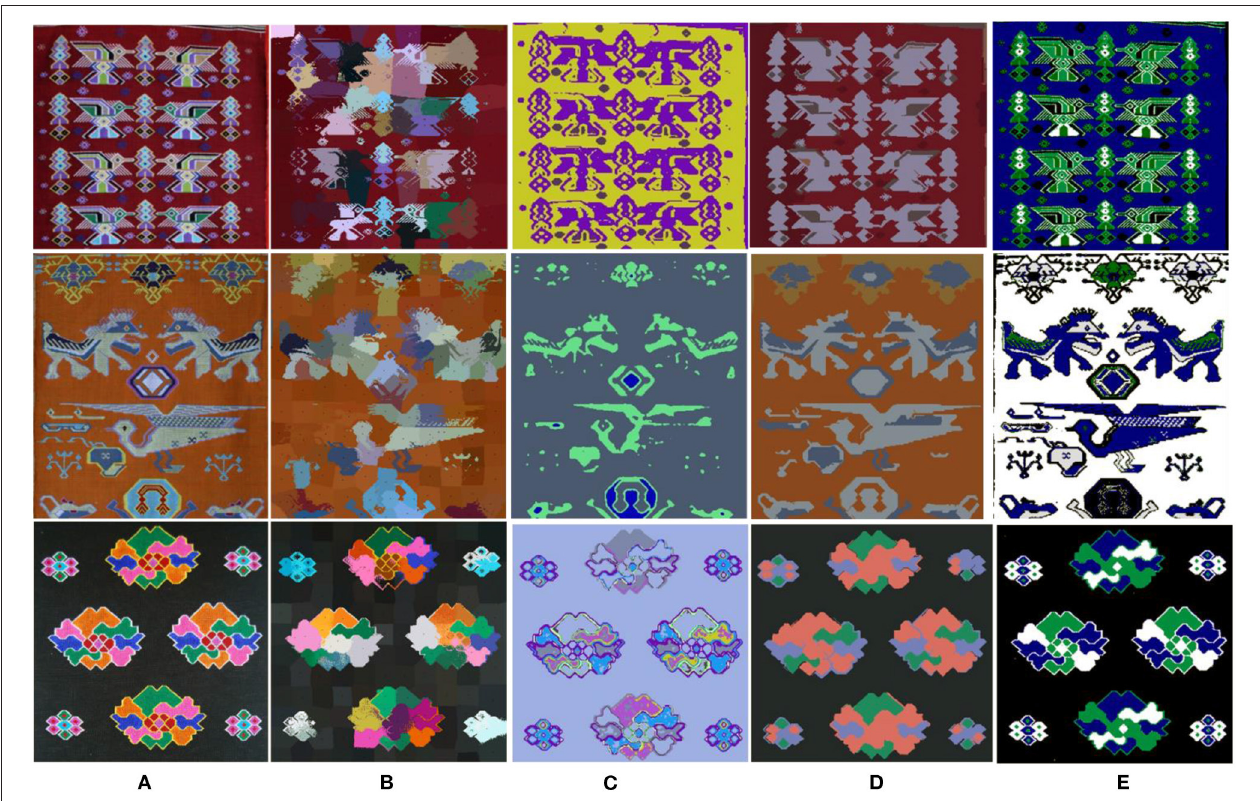
FIGURE 10 | Contrast classic image segmentation algorithms and the method. (A) Original. (B) SLIC. (C) DCN. (D) Unsupervised Image Segmentation. (E) Our method. the approach. The CH calculation formula (13) (Liu et al., 2020) is as